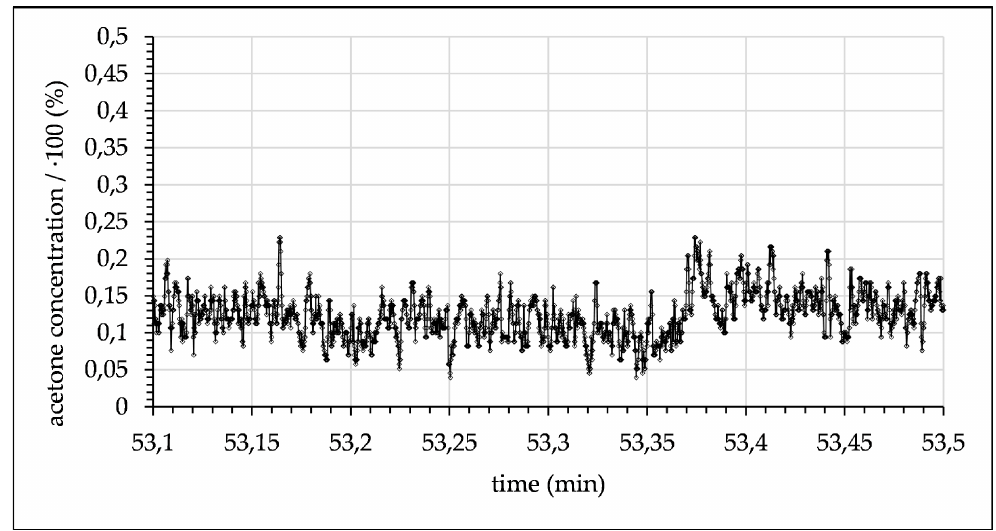
Figure 13. Measured acetone concentration in toluene droplets alternating with water phase (0.006 mL/min with a 25 s time delay after contact of toluene and water).